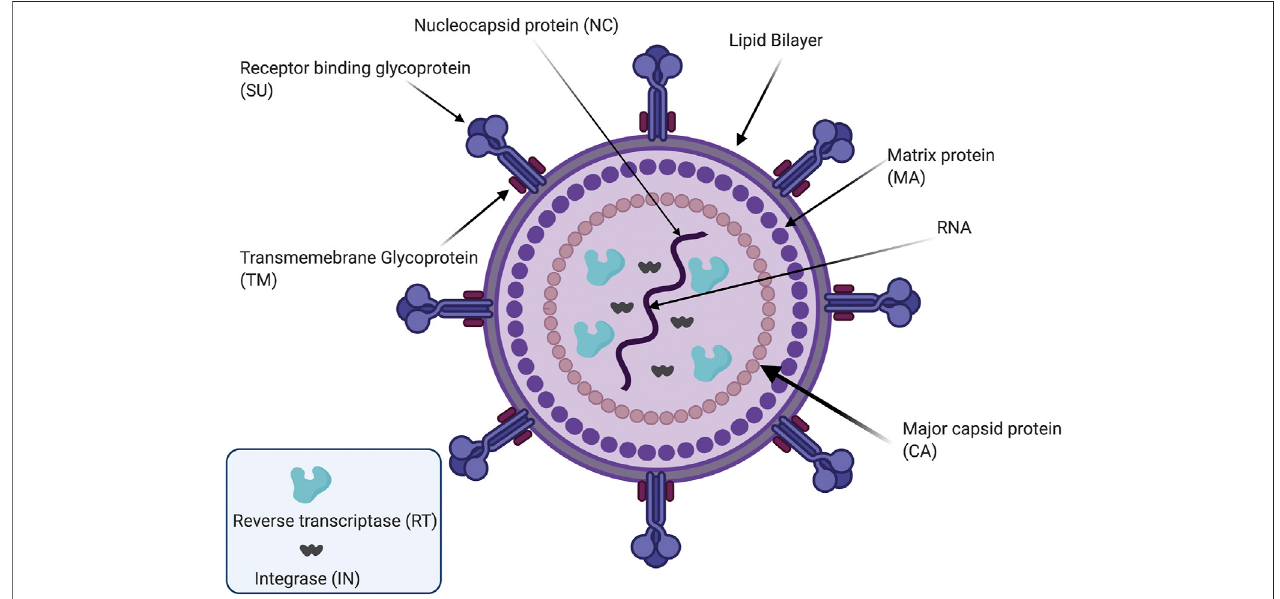
FIGURE 1 | A schematic drawing illustrating the structure of retrovirus. The virus is surrounded by a lipid bilayer membrane. The membrane contains the transmembrane (TM) region and receptor binding glycoprotein (SU). The viral matrix protein (MA) covers the internal side of the viral membrane, while the capsid protein (CA) covers the viral core. The viral core is composed of the viral RNA in addition to the nucleocapsid (NC) protein. The viral core also contains viral replicating enzymes integrase (IN), and reverse transcriptase (RT). This fi gure is created by BioRender